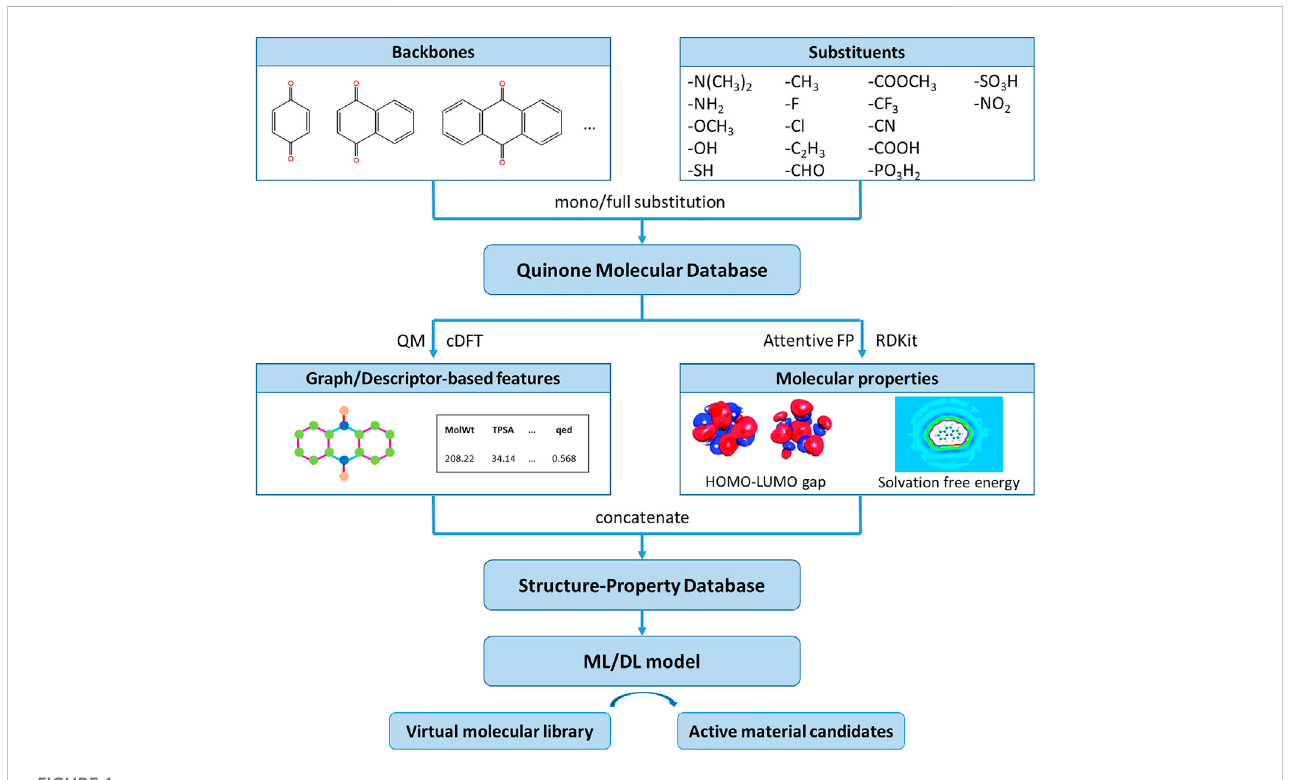
FIGURE 1 The computational scheme for molecular quinone